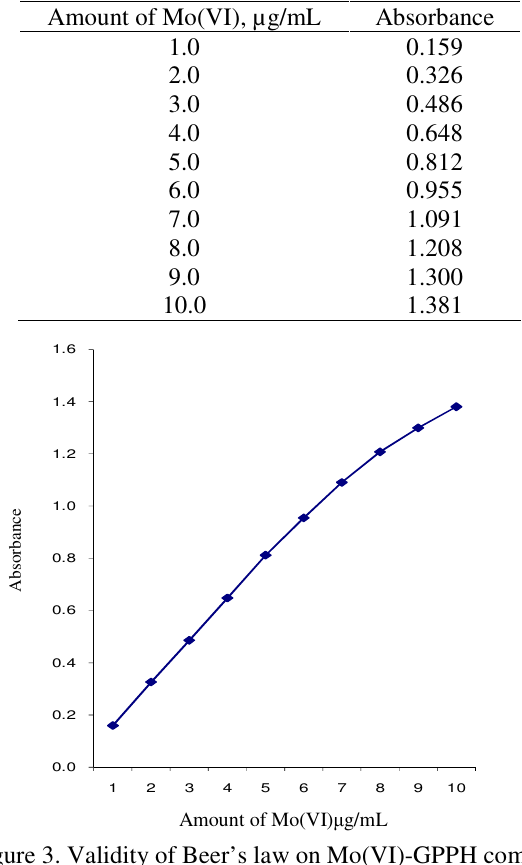
Table 2. Validity of Beer's law on Mo(Vi)-GPPH complex